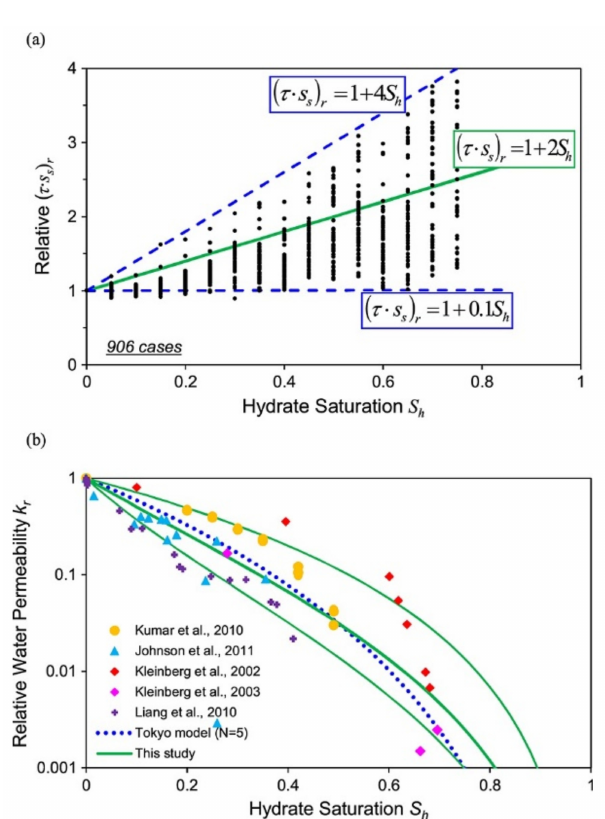
Figure 5. ( a ) Changes in tortuosity and specific surface in sediments due to hydrate formation; ( b ) relative water permeability as a function of hydrate saturation: comparison of models and experimental data [23,42,43,82,89–91]. Reprinted with permission from Ref. [40]. Copyright 2014 American Geophysical